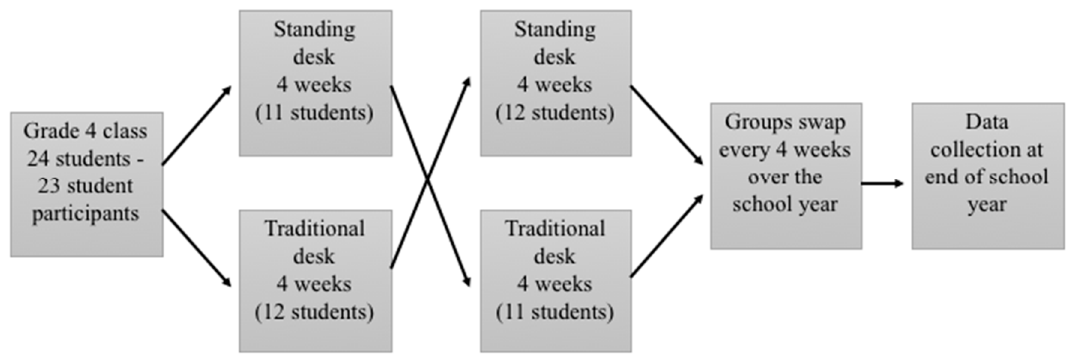
Figure 1. Study design and participant flow.